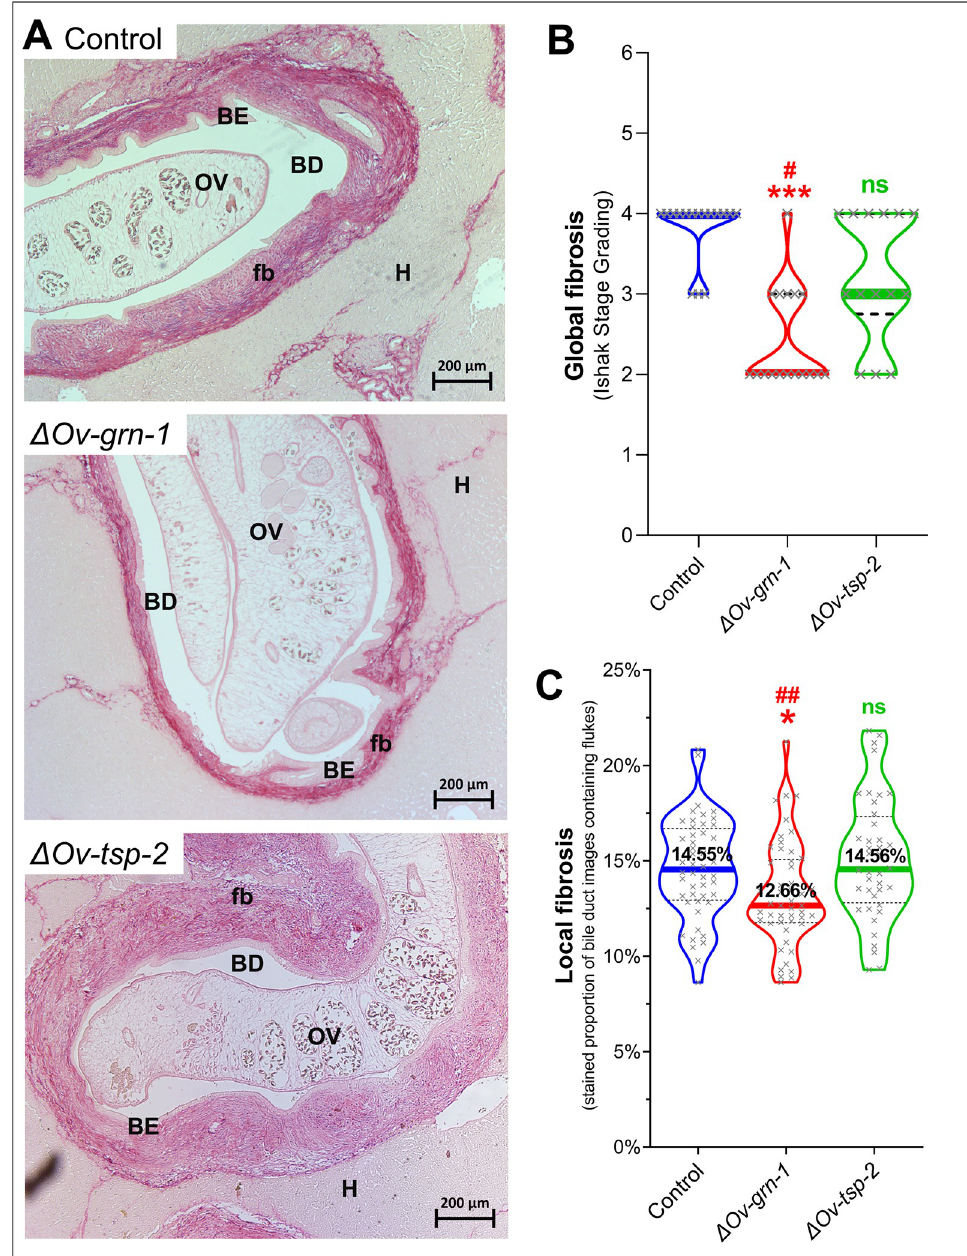
Fig 6. Attenuated liver fibrosis during infection with Δ Ov-grn-1 knockout parasites. Panel A. Representative images of hepatic fibrosis stained by Picro-Sirius Red with CRISPR-Cas9 edited O. viverrini . Fibrosis was denoted as pink/red thick bands around the bile ducts (periductal fibrosis, fb) and expanded from each portal triad with fibrous septa. OV = Opisthorchis viverrini , H = hepatocyte, BD = bile duct, BE = biliary epithelium. B . Global liver fibrosis: Livers were scored for fibrosis using an Ishak Stage grading scale and plotted on the scale spanning from zero (no fibrosis) to six (cirrhosis) (n = 14 to 17 liver lobes per group).). C. Fibrosis proximal to flukes: Automated ImageJ fibrosis evaluation of the percentage of collagen deposition in images surrounding fluke-containing bile ducts (n = 46 to 54 images per group). Panels B, C: medians shown as thick colored line and dashed black lines mark the inter-quartile ranges. Kruskal-Wallis test with Dunn’s multiple comparisons: against the control group, ns = not significant; � , P � 0.05; ��� , P � 0.001, and against the Δ Ov-tsp-2 group: #, P � 0.05; ##, P � 0.01.